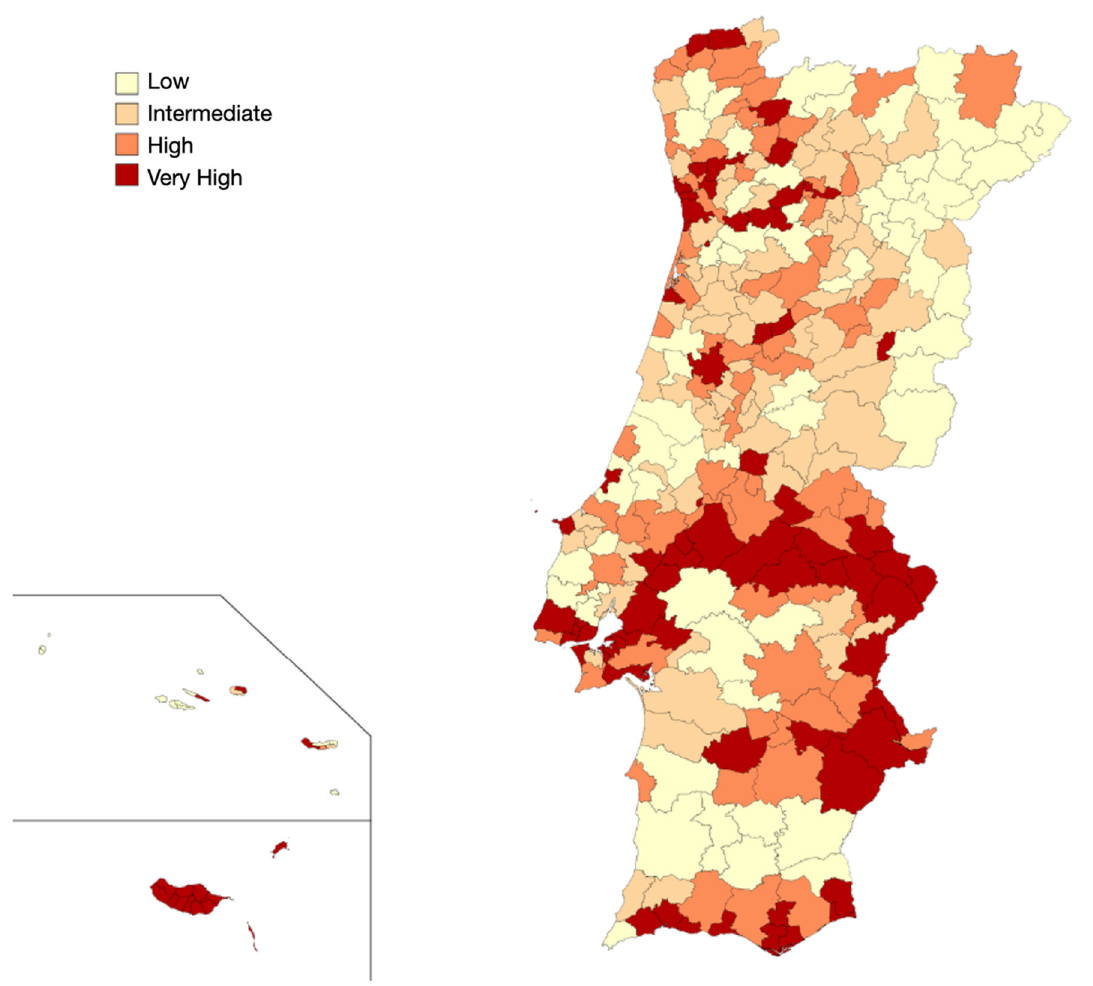
Figure 1. National distribution of the periodontitis risk grade for each LAU 1 (municipality) within the correspondent cluster. The municipalities are identified in a 4-level color risk grade, by quartile position: from Q1—higher risk (red) to Q4—lower risk (yellow).